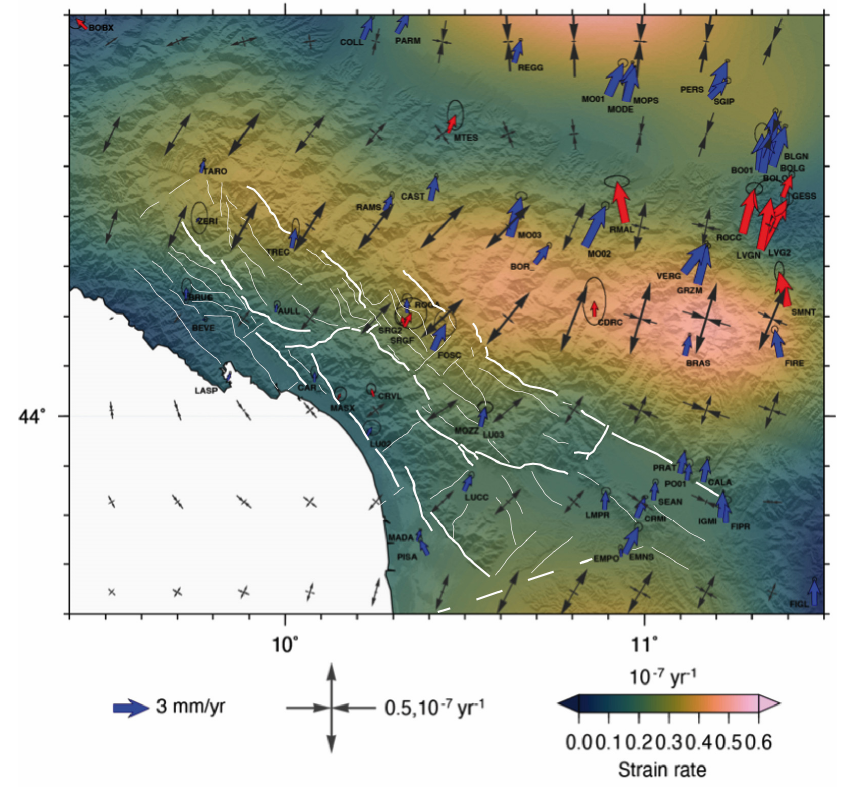
Figure 11. Horizontal GPS velocity field (blue and red vectors are continuous and campaign stations, respectively, with 95% confidence error ellipses) and total strain-rate field (color scale). The diverging and converging grey arrows show the axes of the principal strain rates, indicating extensional and contractional deformation, respectively.